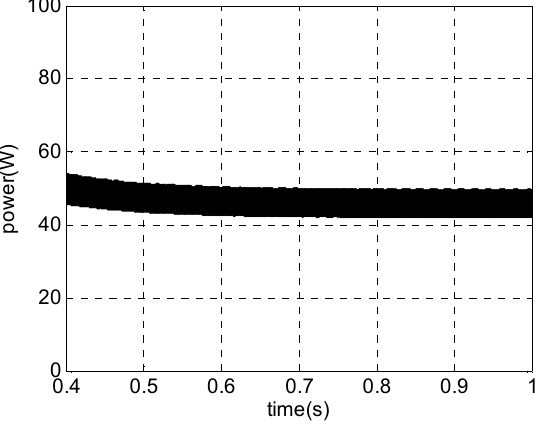
Figure 19. Simulations results for a PMSG. For v wind = 3 m/s: electrical power. Voltage and current signals on the controlled semiconductor S 1 can be seen on Figure 20, for both cases, v wind = 12 m/s and v wind = 3 m/s. It shows the ZCS characteristic, once S 1 is turned off with no current flowing.